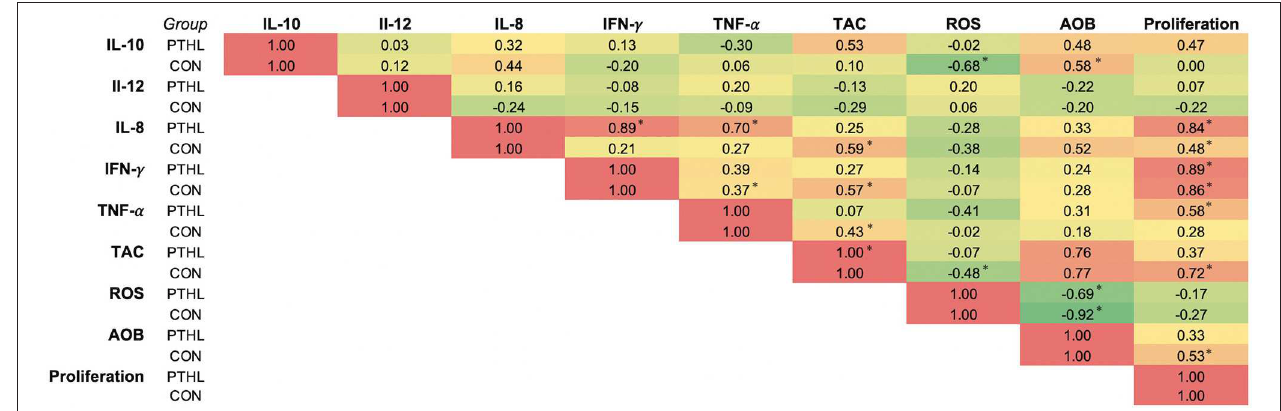
FIGURE 6 | Correlation analysis of panel of cytokine, oxidative stress measurements, and cell proliferation of the CON and PTHL group. * P <